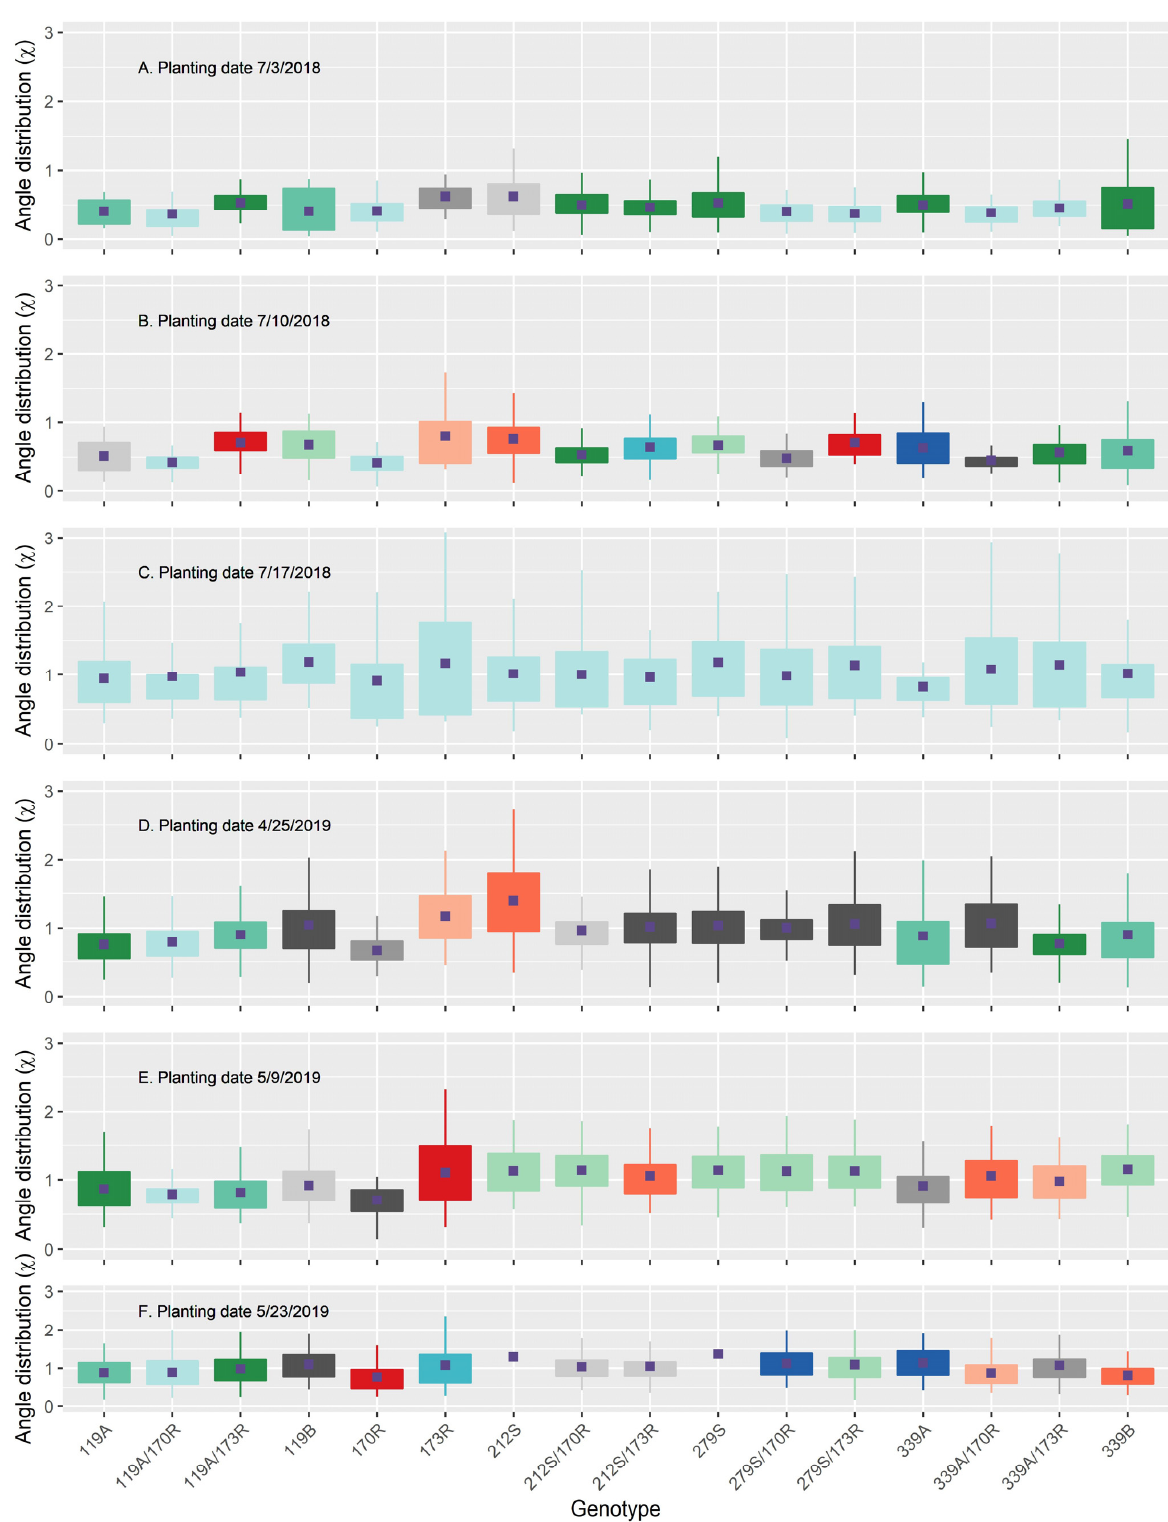
Figure 9. Leaf angle distribution and multiple comparisons for different rice genotypes: ( A ) Planting date 7/3/2018; ( B ) Planting date 7/10/2018; ( C ) Planting date 7/17/2018; ( D ) Planting date 4/25/2019; ( E ) Planting date 5/9/2019; ( F ) Planting date 5/23/2019. Genotypes with the same color in a plot are not significantly different from each other at 0.05 with Tukey’s HSD multiple comparison test.